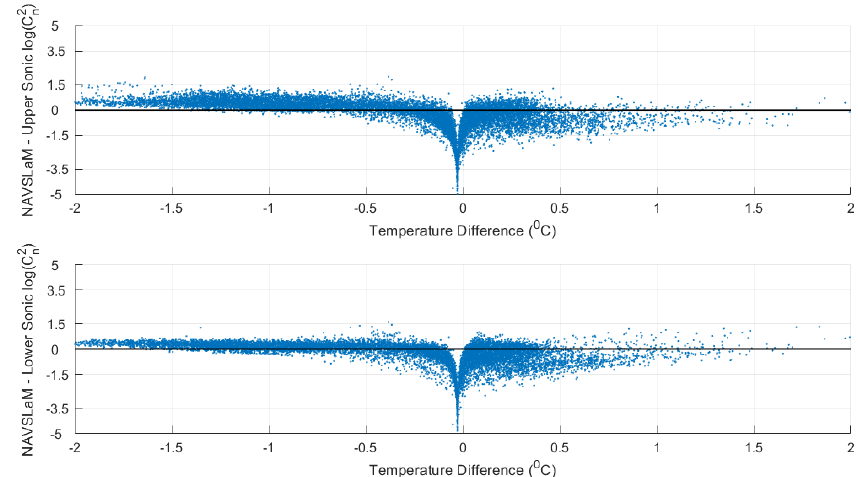
Figure 6. Summary plots for the entire experimental period, showing 𝑙𝑜𝑔(𝐶 𝑛2 ) from NAVSLaM estimates and CSAT3 sonic anemometer measurements versus the temperature difference between the upper and lower sonic locations. A temperature difference of zero indicates near-neutral conditions.